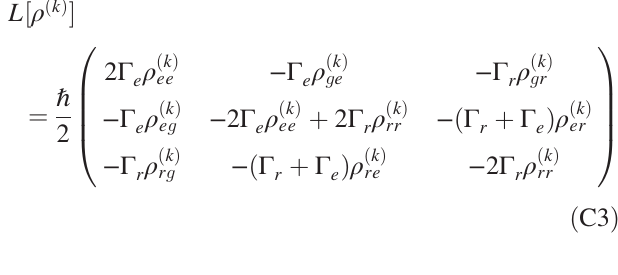
47 D 3 = 2 (right) 3 = 2 , m J ¼ proportional to the ion